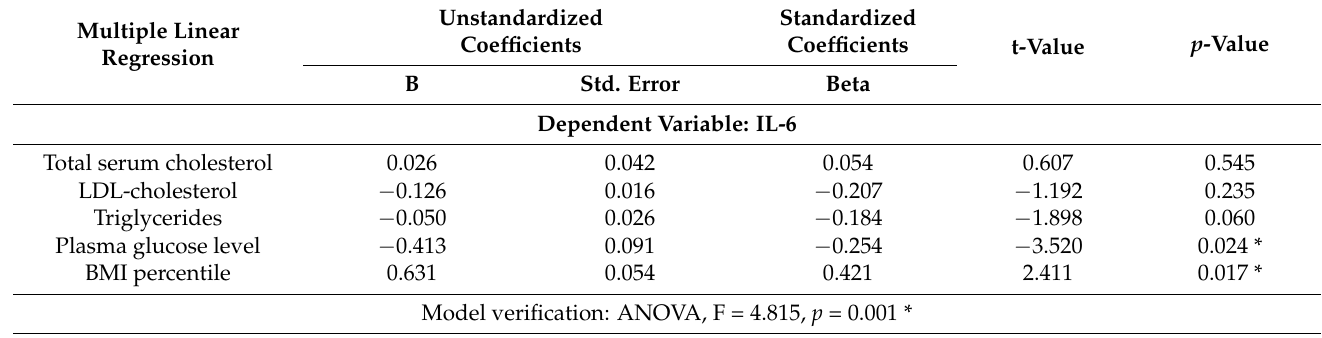
Table 3. The coefficients of multiple linear regression regarding the correlations between early inflammatory markers of cardiovascular risk and BMI percentile and biochemical parameters.